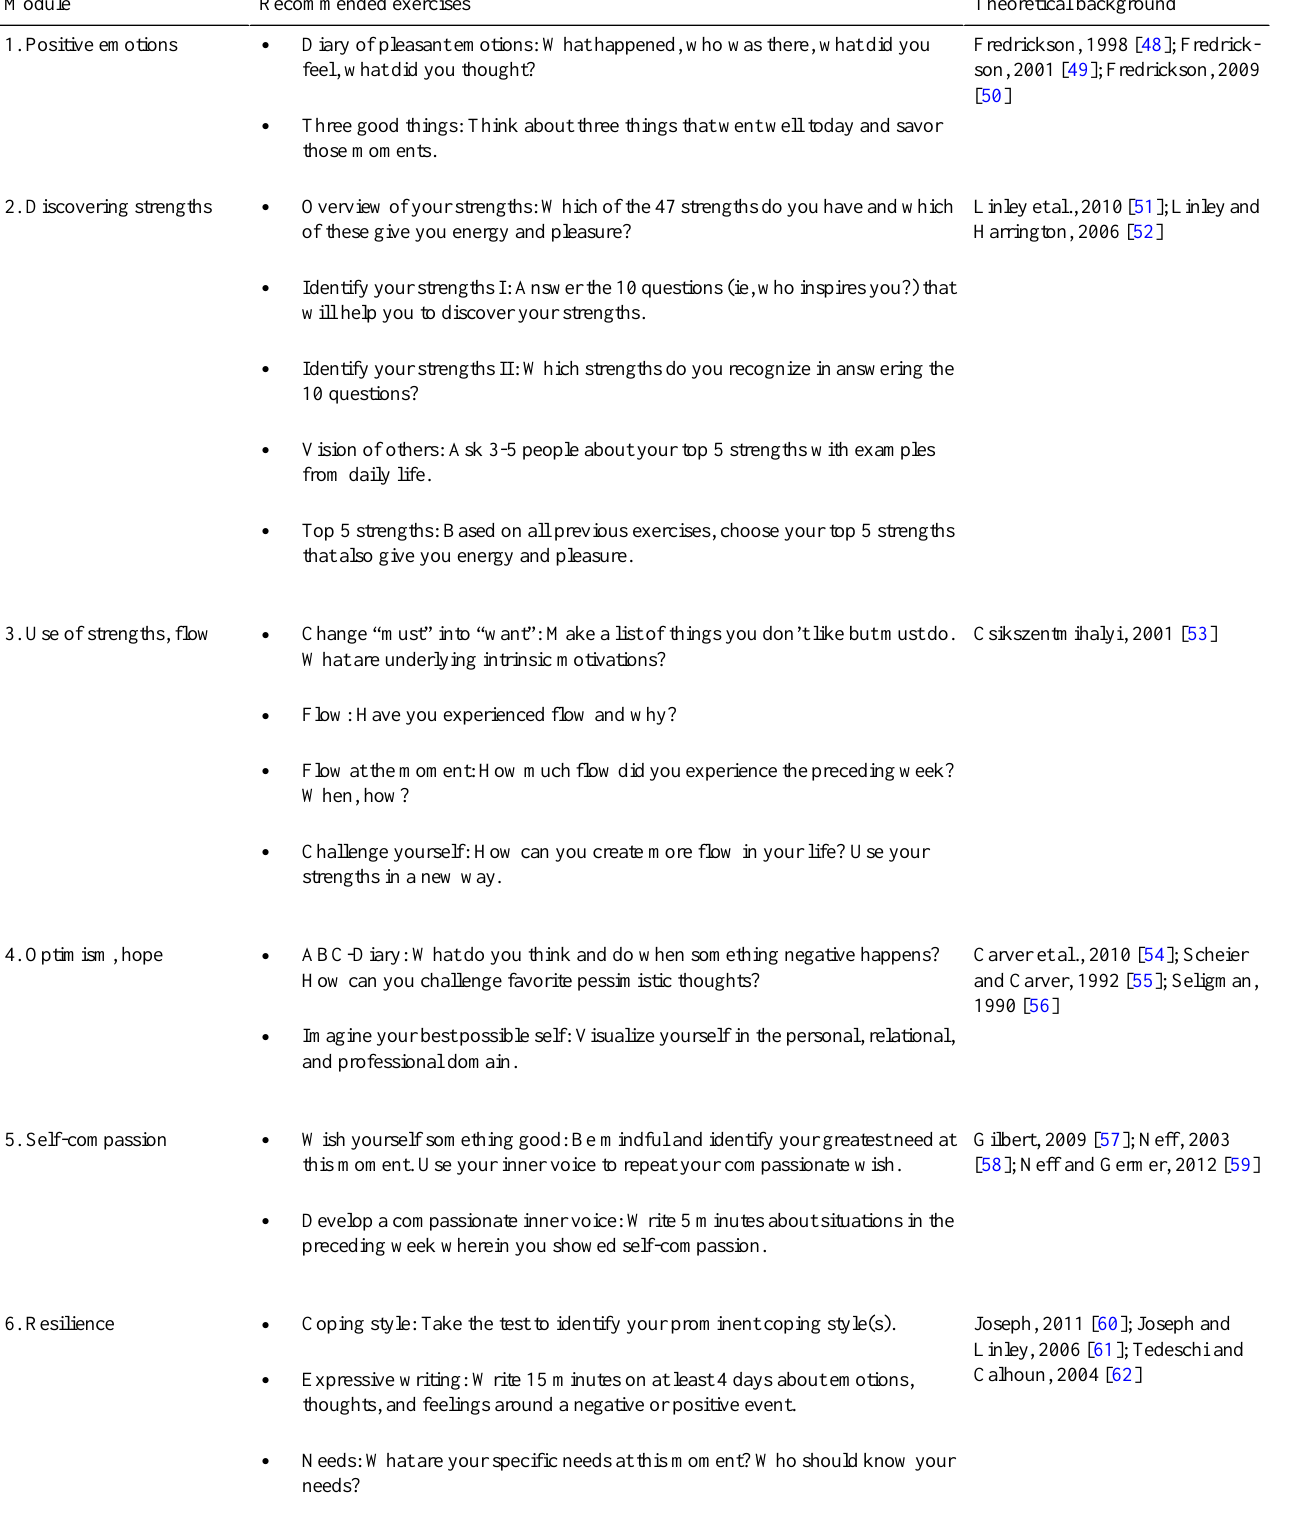
Theoretical backgroundRecommended